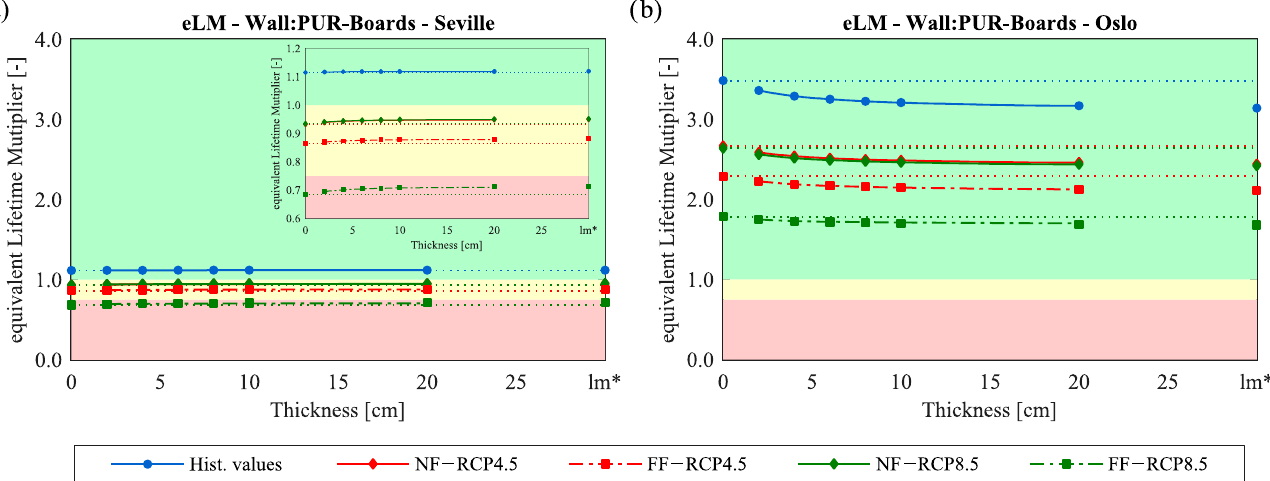
Figure 5. Chemical decay assessment (eLM) for the case study with PUR boards for Seville ( a ) and Oslo ( b ). This figure shows the results for historical, near-future, and far-future time frames for the case study with a wall retrofit measure and for the case without retrofits (dotted lines). lm* is an additional “virtual” thickness that corresponds to a 30 cm layer